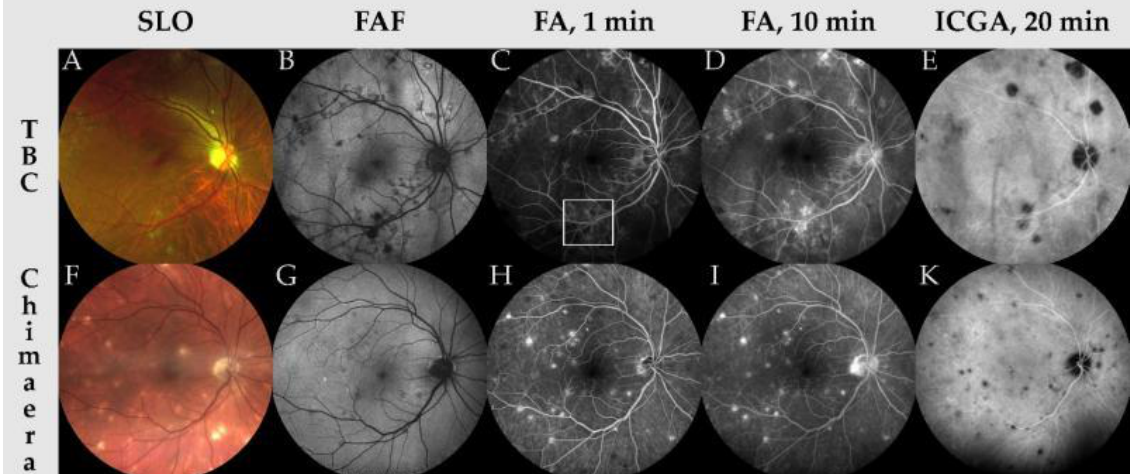
Figure 2. Multimodal imaging findings of patients suffering from multifocal choroiditis due to M. tuberculosis (TBC, A – E ) and M. chimaera (F – K). In both scanning laser ophthalmoscopy images (SLO, A , F ) choroidal granulomas can be observed. Note that panel A was acquired using an OPTOS device (OPTOS Inc., Marlborough, MA, USA) using a green and red laser, while panel F was acquired using a ZEISS Clarus device (Carl Zeiss Meditec, Inc., Dublin, CA, USA) with red, green and blue lasers, hence the difference in false color scheme. Fundus autofluorescence imaging (FAF, B , G ) shows hypoautofluorescence at the location of choroidal granulomas, indicating loss of retinal pigment epithelium. In fluorescein angiography imaging at 1 min and 10 min (FA, C , D , H , I ) early hypofluorescence in active lesions (panel C, inside white frame) and late-stage staining of choroidal granulomas can be appreciated. Note that in M. chimaera -associated multifocal choroiditis (MFC), hyperfluorescence seems to be more focused on the choroidal lesions while in M. tuberculosis -associated MFC the hyperfluorescences are more diffuse. In indocyanine green angiography imaging (ICGA, E , K ), hypocyanescent lesions indicate the location of choroidal granulomas.